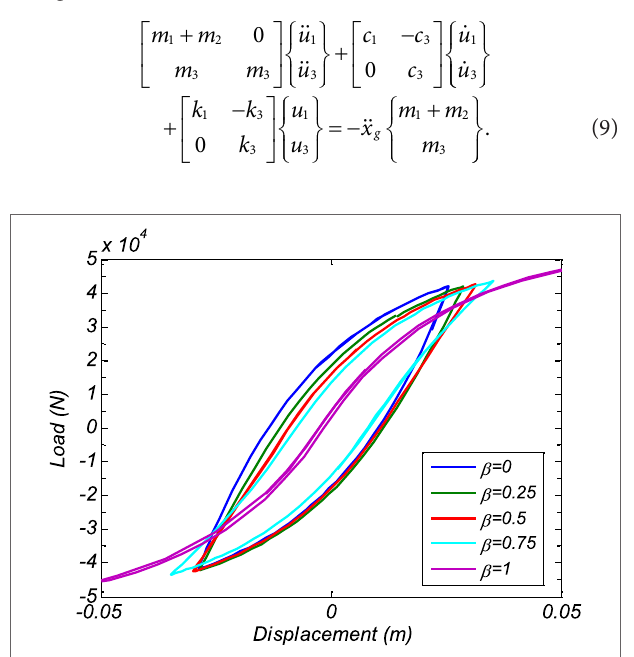
FigUre 4 | Example of hysteretic plots with the Bouc–Wen